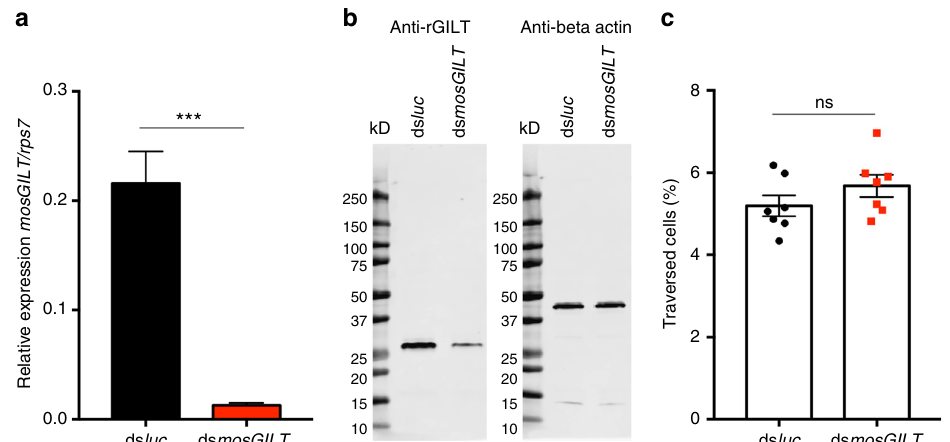
Fig. 5 Analysis of a partial knock-down of mosGILT and the impact on sporozoite cell traversal ( a ) RT-qPCR of SGs injected with either dsRNA targeting an irrelevant luciferase gene or mosGILT . Data represent duplicate experiments from more than three experiments (mean ± SD, unpaired t -test, *** p < 0.0005). b Western blots of SGs from ds luc or ds mosGILT injected mosquitoes. c Cell traversal assay of murine hepatic cells incubated with P. berghei sporozoites isolated from ds luc or ds mosGILT salivary glands (2000 sporozoites/well). Cell traversal by sporozoites was analyzed on a Stratedigm fl ow cytometer by measuring the percentage of fl uorescent dextran positive cells. Each point represents a technical replicate pooled from two independent experiments ( n = 7, ns not signi fi cant)